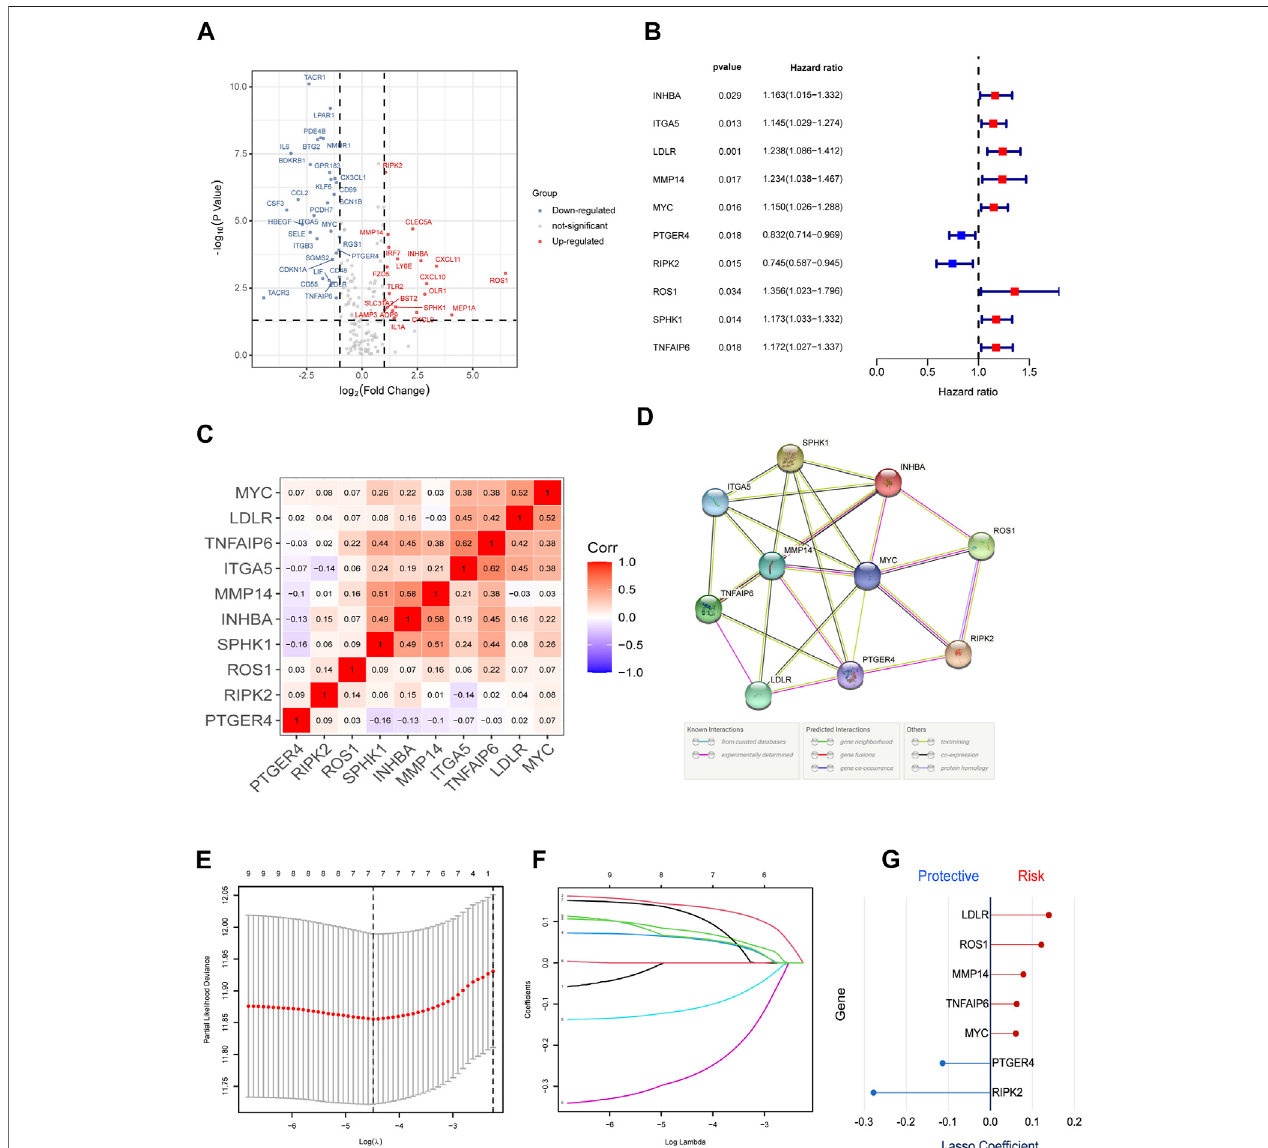
FIGURE 2| Identi fi cation of the candidate IRGswithin the TCGA cohort. (A) Volcano plot to identify DEGs between bladder cancer tissues and normal tissues. (B) Univariate Cox Regression to screen out prognostic signature gene sets. (C,D) C-MAP and PPI network. (E-G) LASSO regression analysis to optimize the signature.